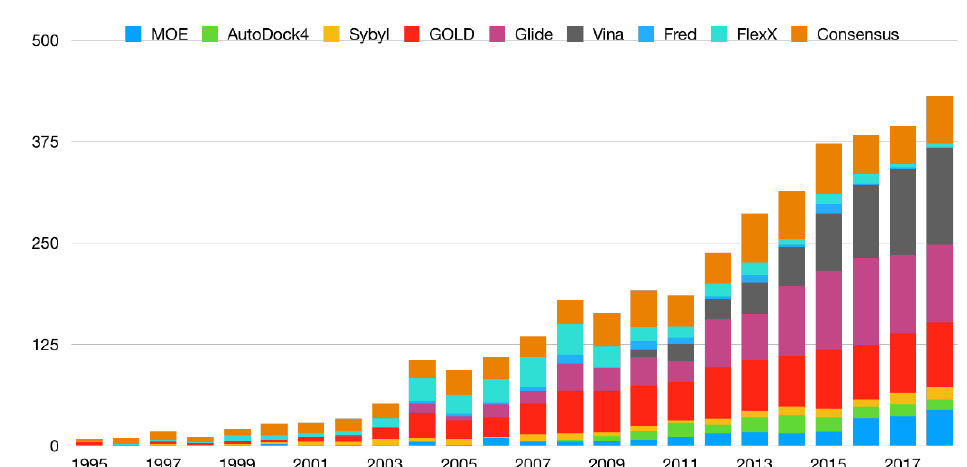
Figure 2. Scopus search results for the query “ TITLE-ABS-KEY ( software AND docking) AND PUBYEAR > 1994 AND PUBYEAR < 2019 ” where the word software is substituted for one of the eight most common docking software or by the word consensus.